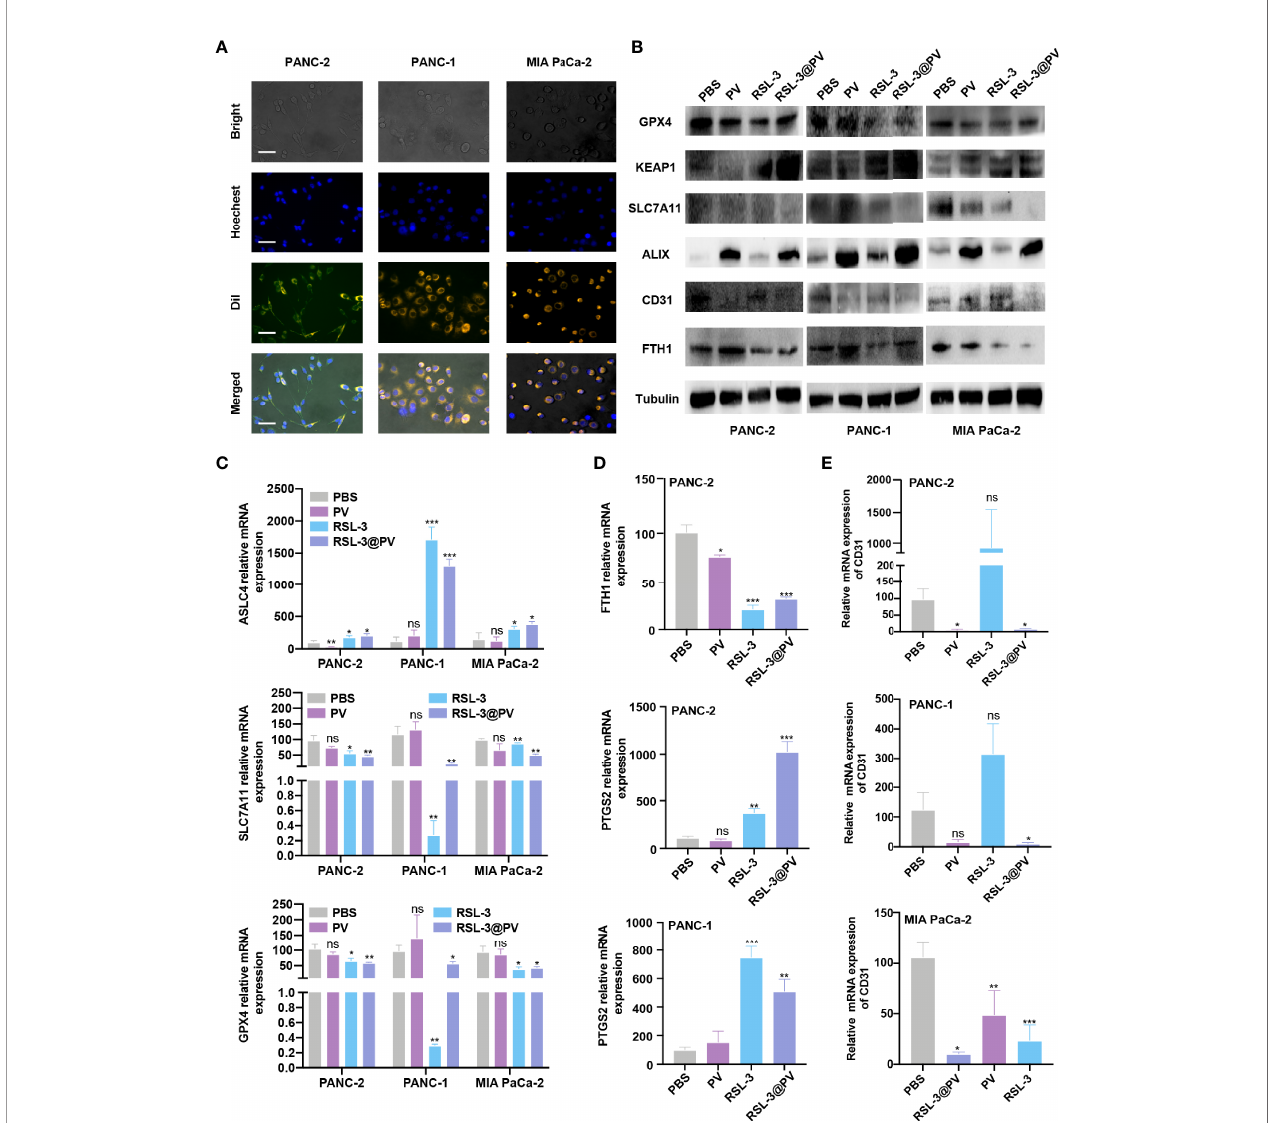
FIGURE 2 | In vitro cell targeting of RSL-3@PVs. (A) Inverted optical microscope images of PANC-2, PANC-1, MIA PaCa-2 treated with RSL-3@PVs. Cell nuclei and membranes were labeled with DAPI and DiI, respectively. Scale bars: 200 m m. (B) Western blot analysis of the ferroptosis core regulators and vesicle marker in PANC-2, PANC-1, MIA PaCa-2 treated with PBS, PV, RSL-3 and RSL-3@PVs. (C – E) Relative mRNA expression of ASLC4 , SLC7A11 , GPX4 (C) , FTH1 , PTGS2 (D) , CD31 (E) . Error bars represent the mean ± s.d. One-way ANOVA was used for multiple comparisons, ns P > 0.05, *P < 0.05, **P < 0.01, and ***P <